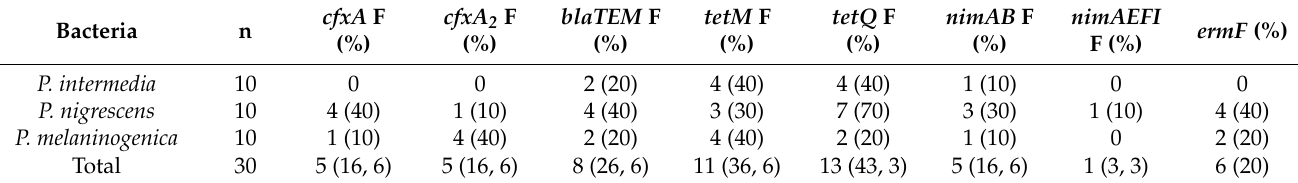
Table 4. Frequency of genes cfxA, cfxA 2 , bla TEM , tetM, tetQ, ermF, nimAB, and nimAEFI in 30 oral isolates of Prevotella intermedia, P. nigrescens, and P. melaninogenica